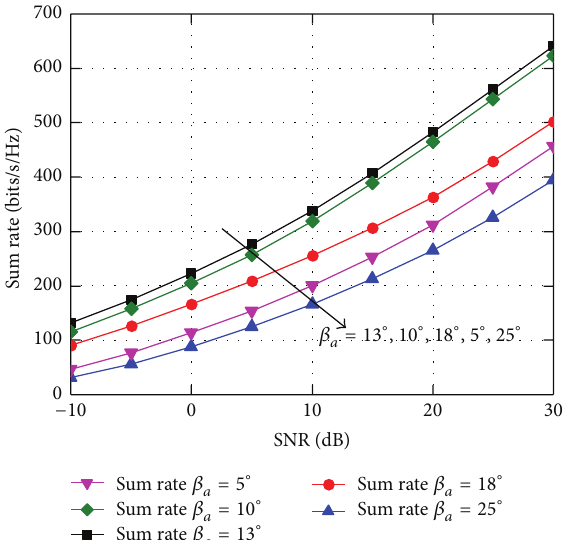
Figure 3: Simulated sum rate against the tilt angle for three user distributions ( 𝑝 𝑢 = 5 dB, 𝑁 𝑟 = 50 , 𝑁 𝑡 = 2 , 𝐿 = 3 , 𝐾 = 24 , 𝐷 = 200 m, 𝑅 = 100 m, 𝜐 = 4 , UD: uniform distribution, ND: normal distribution, and LD: linear distribution).